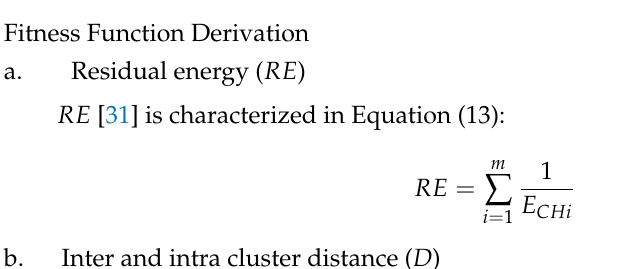
Figure 2. Flowchart of clustering and routing using ED-MORFO.